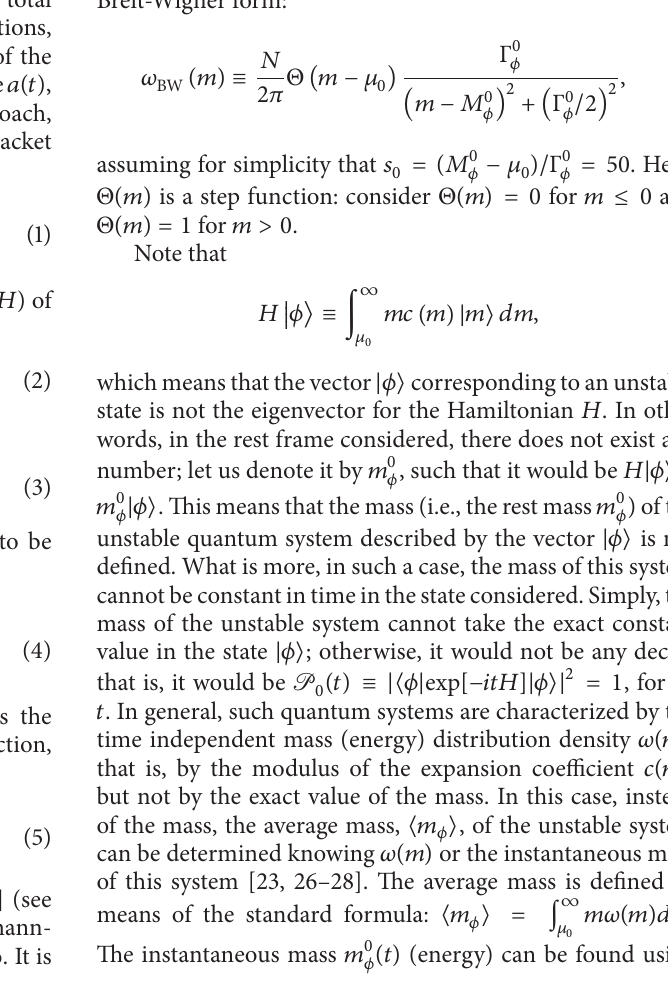
because, from the normalization condition ∫